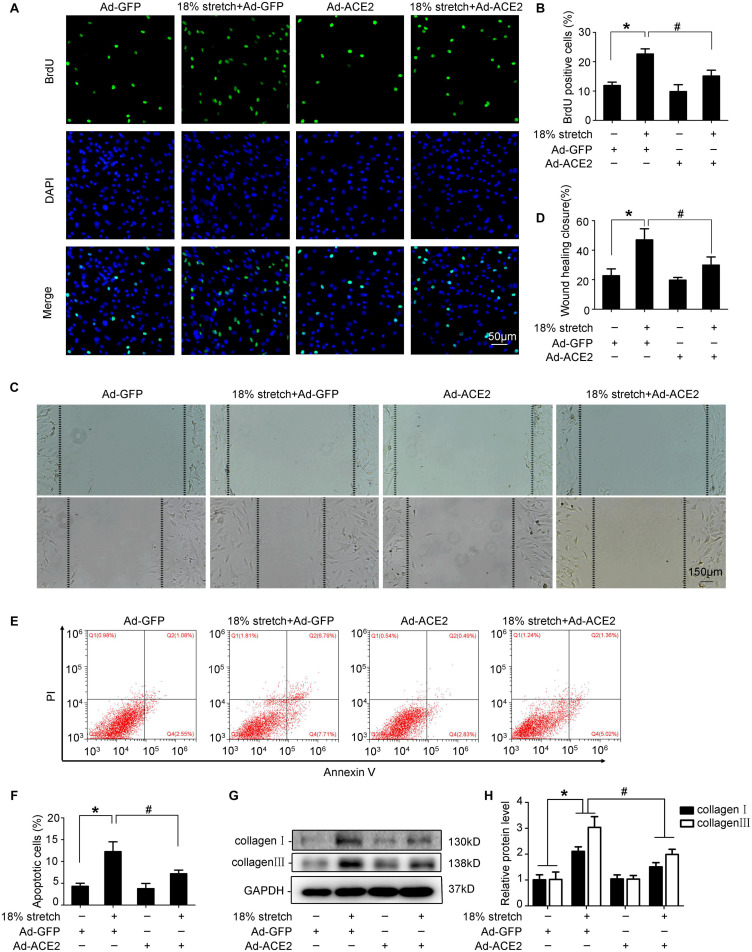
ACE2 was involved in mechanical stretch-induced vascular smooth muscle cells (VSMC) dysfunction. VSMCs were transfected with Ad-ACE2 or Ad-GFP for 24 h and then exposed to mechanical stretch (18% elongation, 1 Hz) for 12 h or not. (A,B) Representative views of BrdU-positive cells in different conditions and the percentage of BrdU-positive cells out of total cells. (C,D) Representative views of migration distance in different conditions. (E,F) Summarized data showing cell apoptosis as determined by flow cytometry analysis in VSMCs. (G,H) Western blot analysis of collagen I and collagen III in VSMCs with or without overexpression of ACE2. Values are expressed as means ± SEM. ∗P < 0.05 vs. Ad-GFP; #P < 0.05 vs. 18% stretch + Ad-GFP (n = 4).